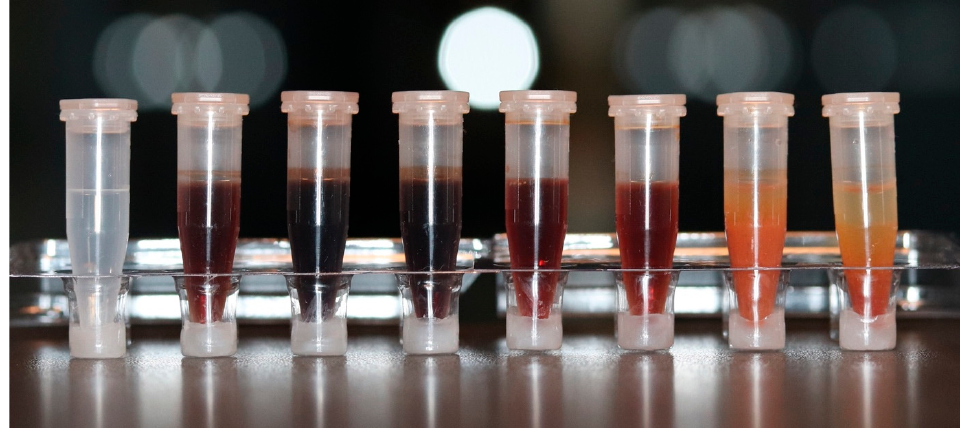
Figure 3. Microtubes containing 2% CHX mixed with different concentrations of NaOCl, to illustrate the precipitate formation. From left to right: (1) control sample with 0% NaOCl; (2) 0.5%; (3) 1%; (4) 1.5%; (5) 2.5%; (6) 3%; (7) 4%; (8) 5%.